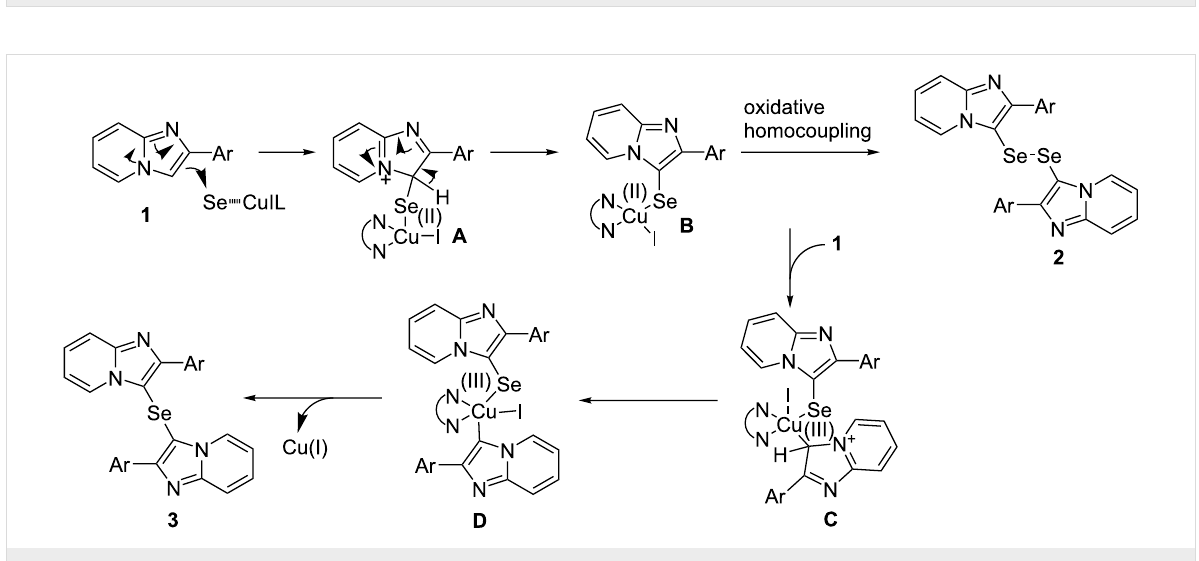
Scheme 1: Control reactions.